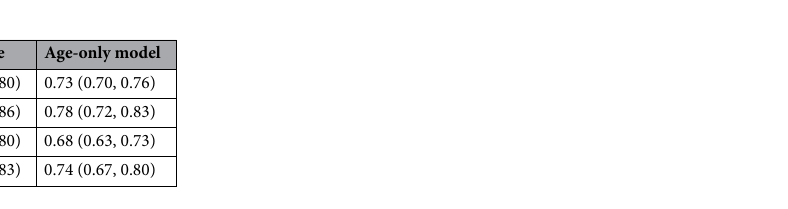
Positive predictive value